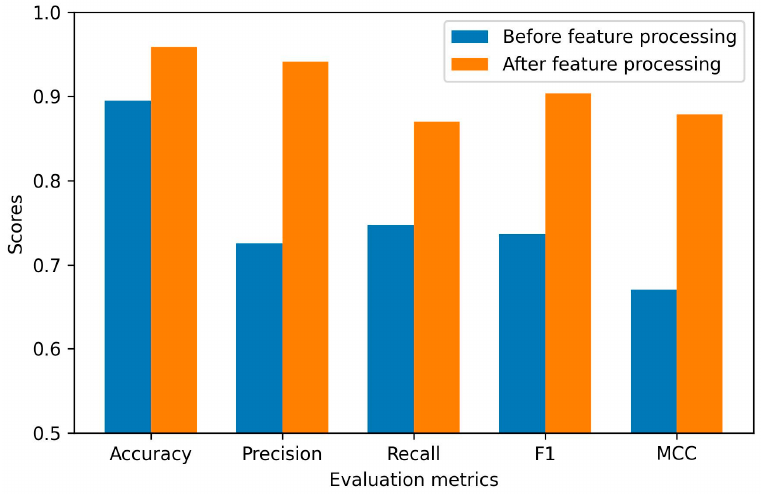
Figure 6. Comparison of classification results with and without feature processing for the proposed method at R =